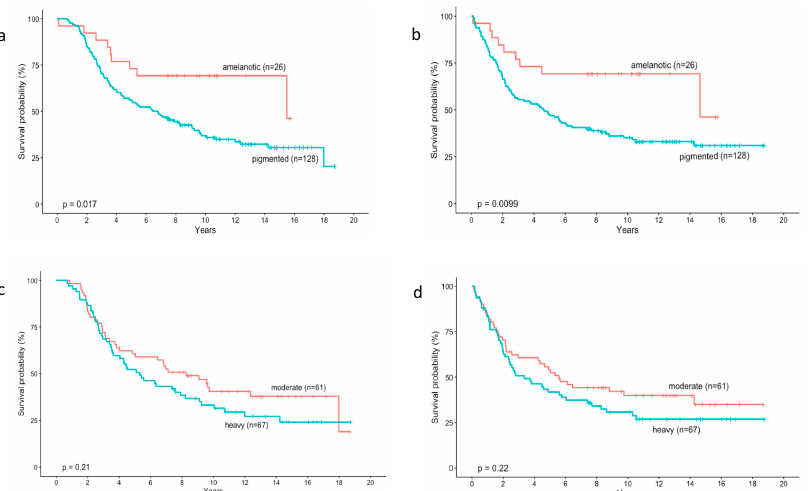
Figure 2. Kaplan–Meier analysis of the prognostic impact of pigmentation degree assessed with indirect ophthalmoscopy in patients with uveal melanoma. Overall survival ( a ) and disease free survival ( b ) were significantly longer in patients with amelanotic tumours. No significant differences in overall survival ( c ) and disease free survival ( d ) between moderately and heavily pigmented tumours were observed.